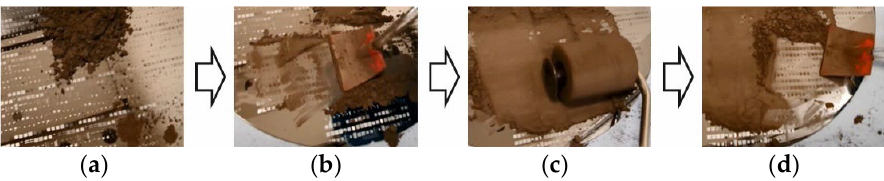
Figure 7. Illustration of the manual filling of a micro mold pattern on an 8” silicon substrate with NdFeB powder. The procedure comprises up to four steps, as follows: ( a ) pouring of the powder onto the substrate; ( b ) spreading of the powder across the substrate; ( c ) optional pressing of the powder into the micro molds for additional compaction to increase the fill factor; ( d ) wiping away the excess powder.